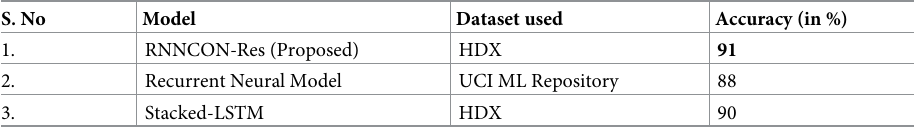
Table 2. Comparison of accuracy delivered by RNNCON-Res with other